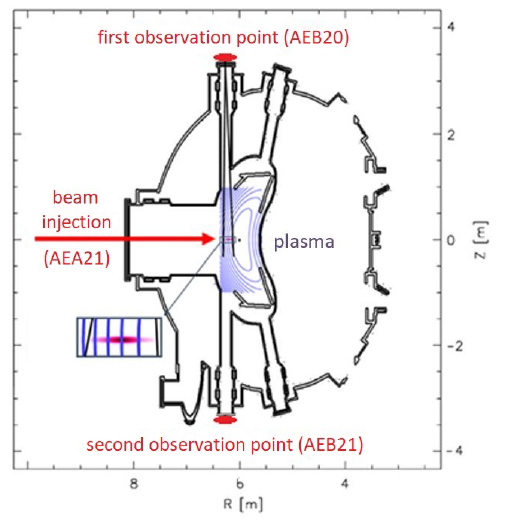
Figure 1. The W7-X alkali metal beam diagnostic system